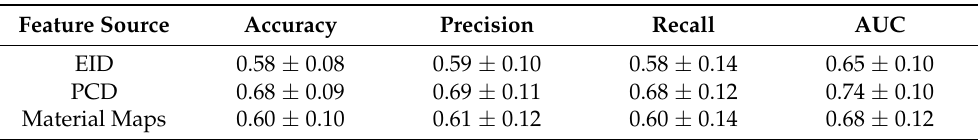
Table 1. Validation test results from classification training for each of the different feature sets. The decision thresholds used in the calculation of accuracy, precision, and recall correspond to the average intersection point of precision and recall within each repeated